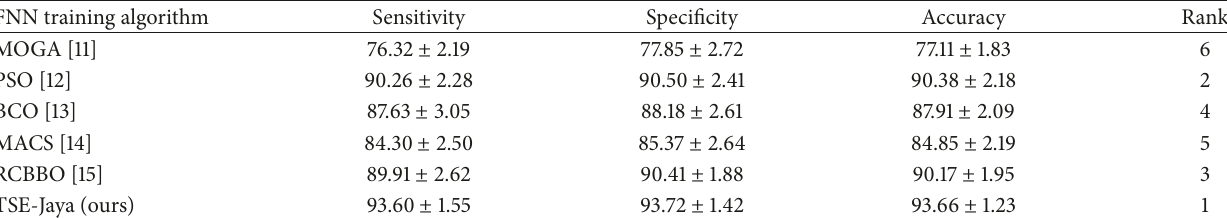
Table 11: FNN training algorithm